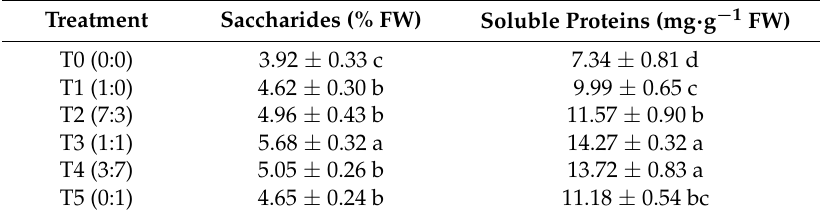
Table 6. Soluble saccharide and protein contents in leaves of Camellia oleifera ‘Xianglin 27’ seedlings fertigated with six nutrient solutions varying in NO 3 − to NH 4+